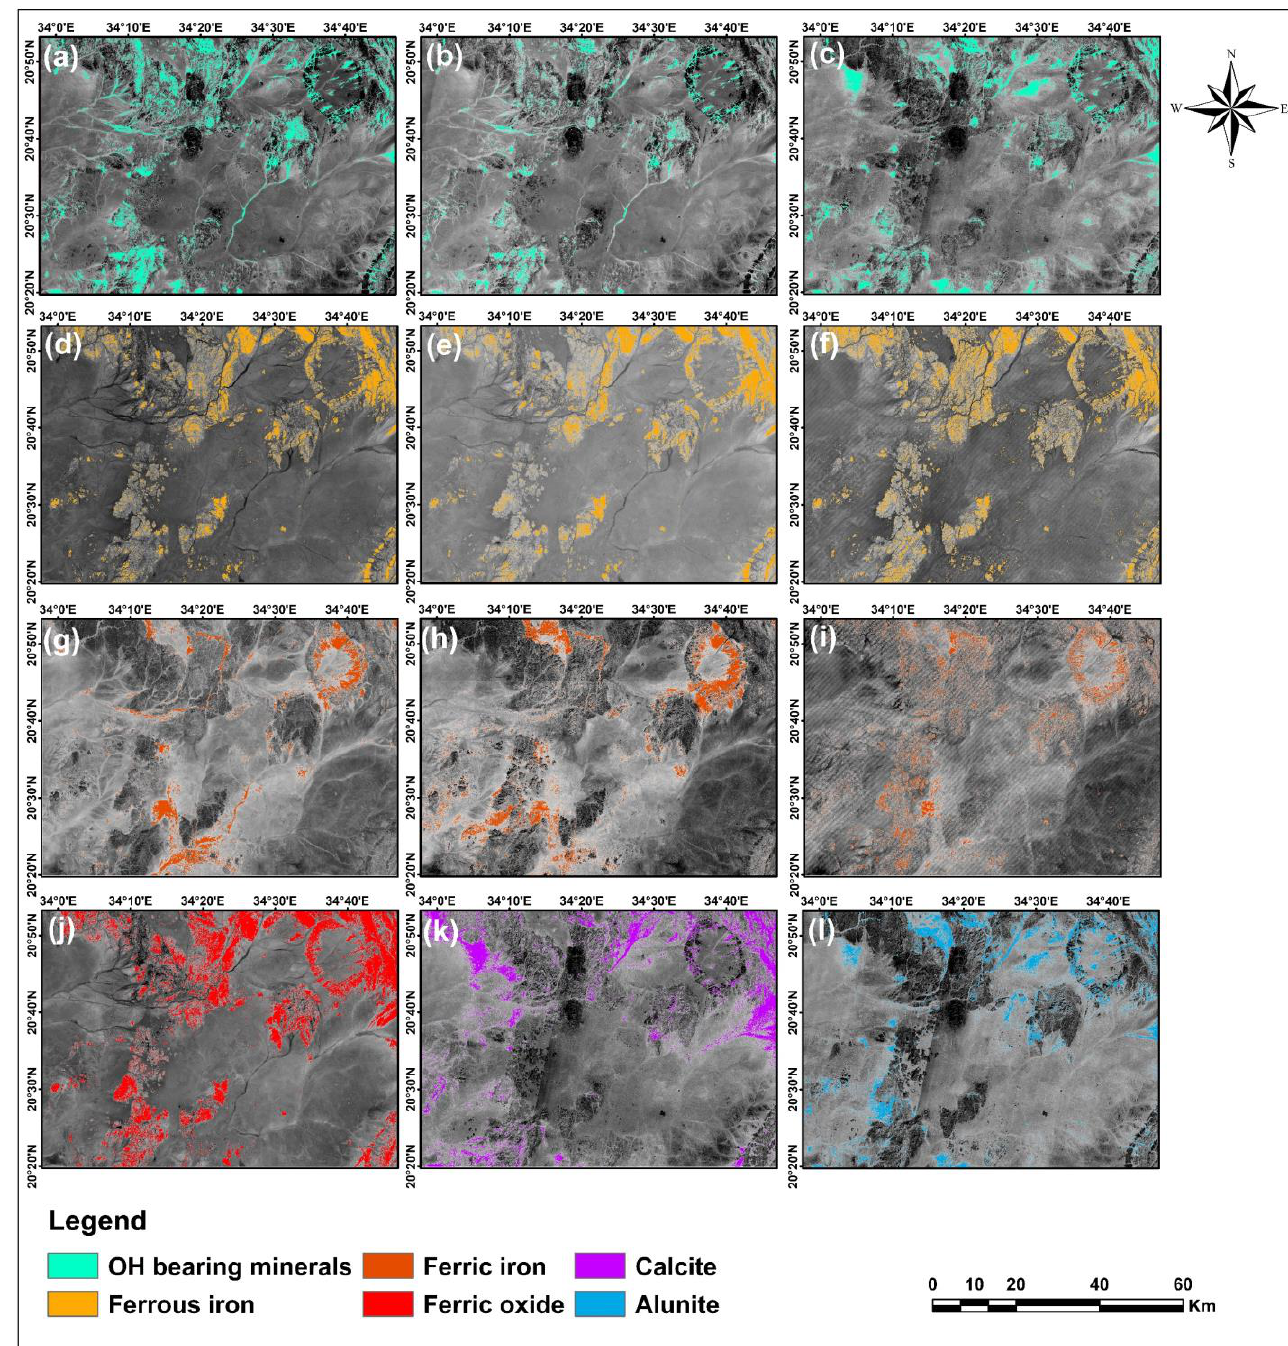
Figure 5. BR images derived from different sensors showing various targeted minerals in colored pixels ( a – c ) Hydroxyl-bearing minerals derived from Landsat-8 (6/7), Sentinel-2 (11/12), and ASTER (4/6), respectively; ( d – f ) Ferrous iron minerals derived from Landsat-8 (7/5 + 3/4), Sentinel-2 (12/8a + 3/4), and ASTER (5/3 + 1/2), respectively; ( g – i ) Ferric iron minerals derived from Landsat-8 (4/2), Sentinel-2 (4/3), and ASTER (2/1), respectively; ( j ) Ferric oxide minerals derived from Sentinel-2 (11/8a); (k and l) Calcite and Alunite minerals derived from ASTER BR 4/7 and 4/5, respectively.